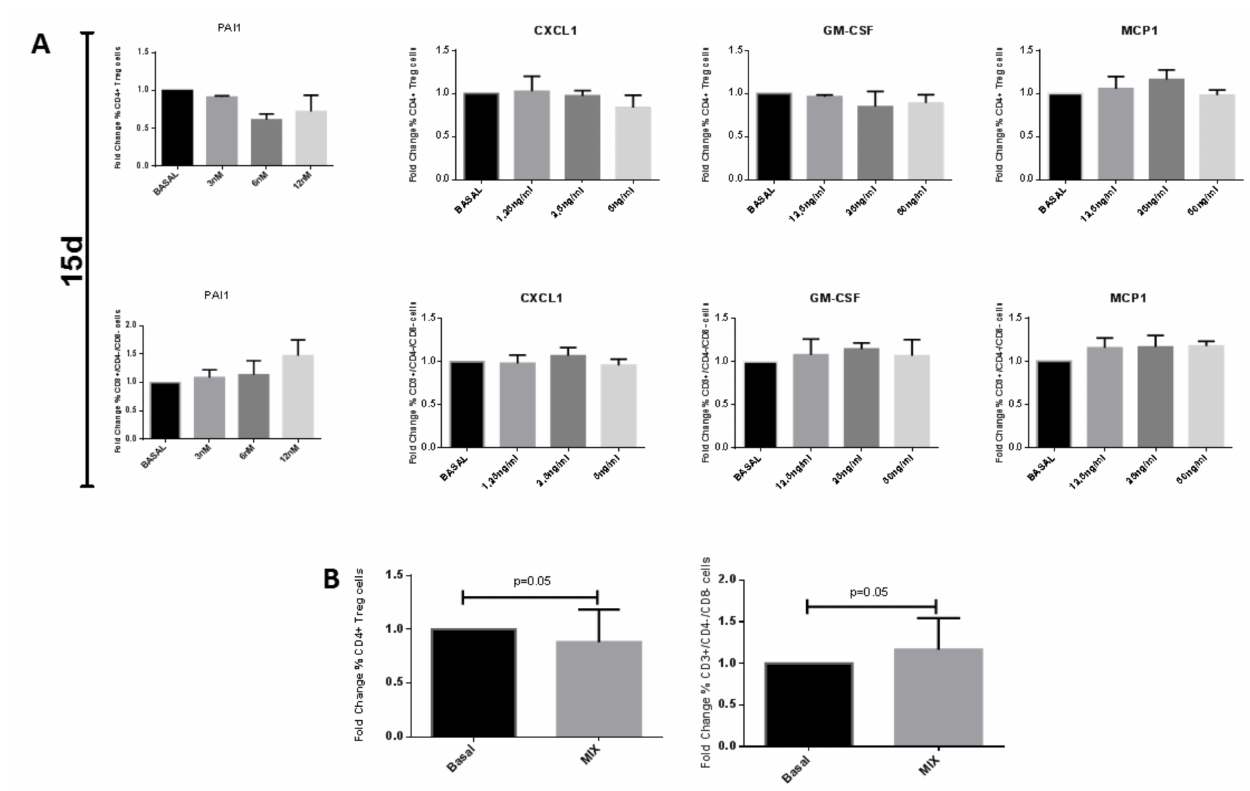
Figure 7. A cocktail of cytokines mediated the immunomodulatory effect of ARPCs after 15 days. ( A ) Con-A activated PBMC were exposed to different crescent concentration of PAI1, CXCL1, GM-CSF and MCP1 for 15 days. None of PAI1, CXCL1, GM-CSF, and MCP1 alone were able to significantly modulate T cell subsets. ( B ) When Con-A activated PBMC were exposed to the 4 cytokines in a mix for 15 days, an immunomodulatory effect was observed on Treg and DN subsets, perfectly comparable to the ARPCs’ co-culture effect. Data represent the fold change of PBMC percentage respect to PBMC Con-A (Basal). Data are representative of six independent experiments (means ±